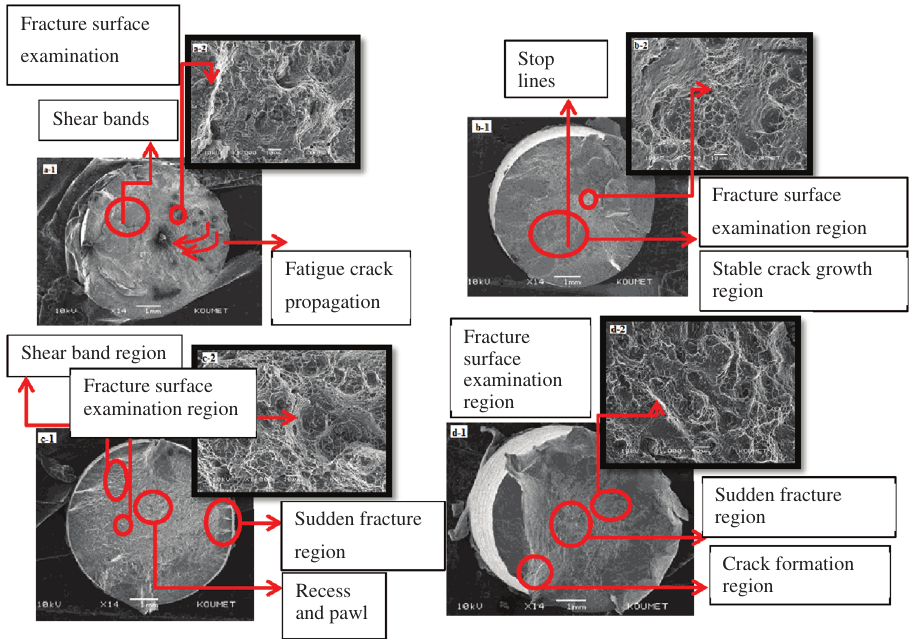
Figure 9: SEM images of fracture surface morphology of ECAPed AA7075 after high-cycle fatigue test; one passed (a1 – a2), two passed (b1 – b2), three passed (c1 – c2) and four passed (d1 –